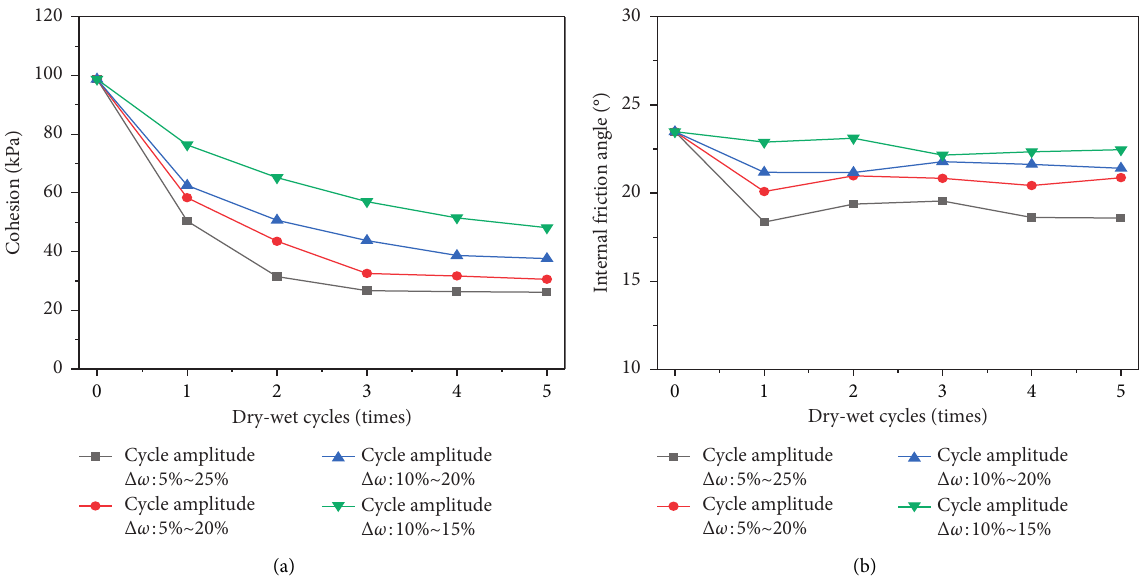
Figure 13: Relationship between the shear strength indexes of different dry-wet cycle amplitudes and Δ w of the Luochuan soil samples. (a) Relationship curve between the cohesion and cyclic amplitude of the soil samples under different dry-wet cycle amplitudes. (b) Relationship curve between the friction angle and cycle amplitude of the soil samples under different amplitudes of dry-wet